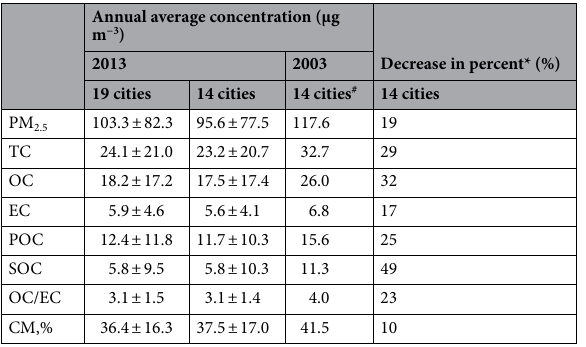
Table 3. Average winter and summer concentrations for PM 2.5 mass and carbonaceous aerosols in 2003 and 2013.